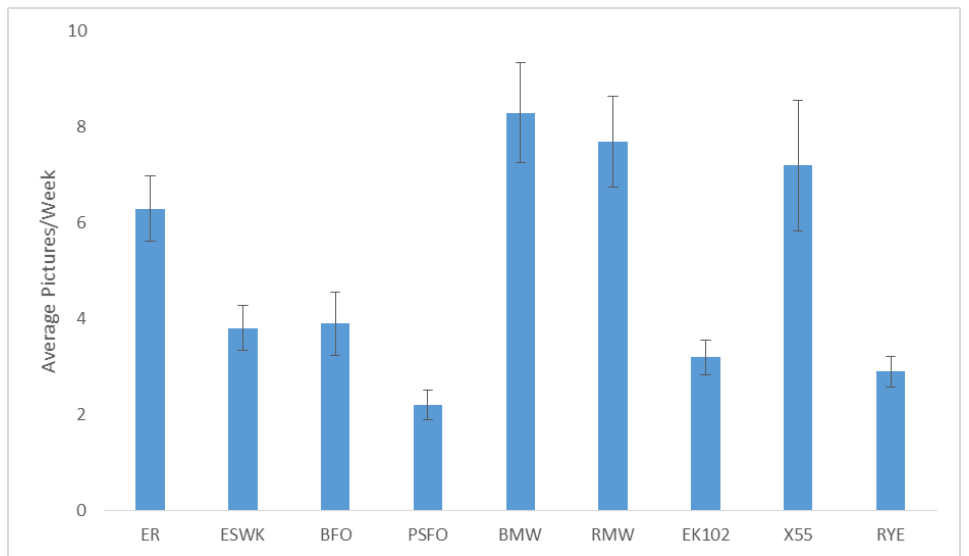
Figure 2. Deer use by plot, average number of deer pictures by week with standard error bars shown. ER = Elbon Rye (cereal rye); ESWK = ES Winter Keeper (oat variety); BFO = Buck Forage Oats; PSFO = Plot Spike Forage Oats; BMW = Buck Master Wheat; RMW = Range Master